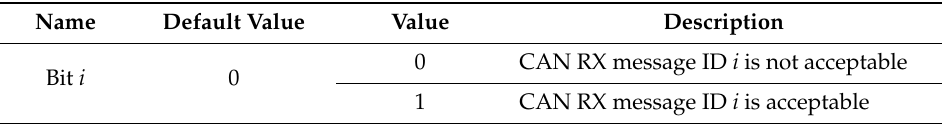
Table 2. Value definition of every RXFilter